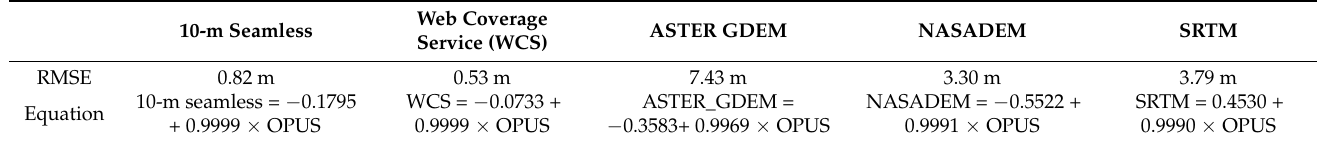
Table 18. Comparison of 3DEP data to various global datasets using OPUS checkpoints ( n =